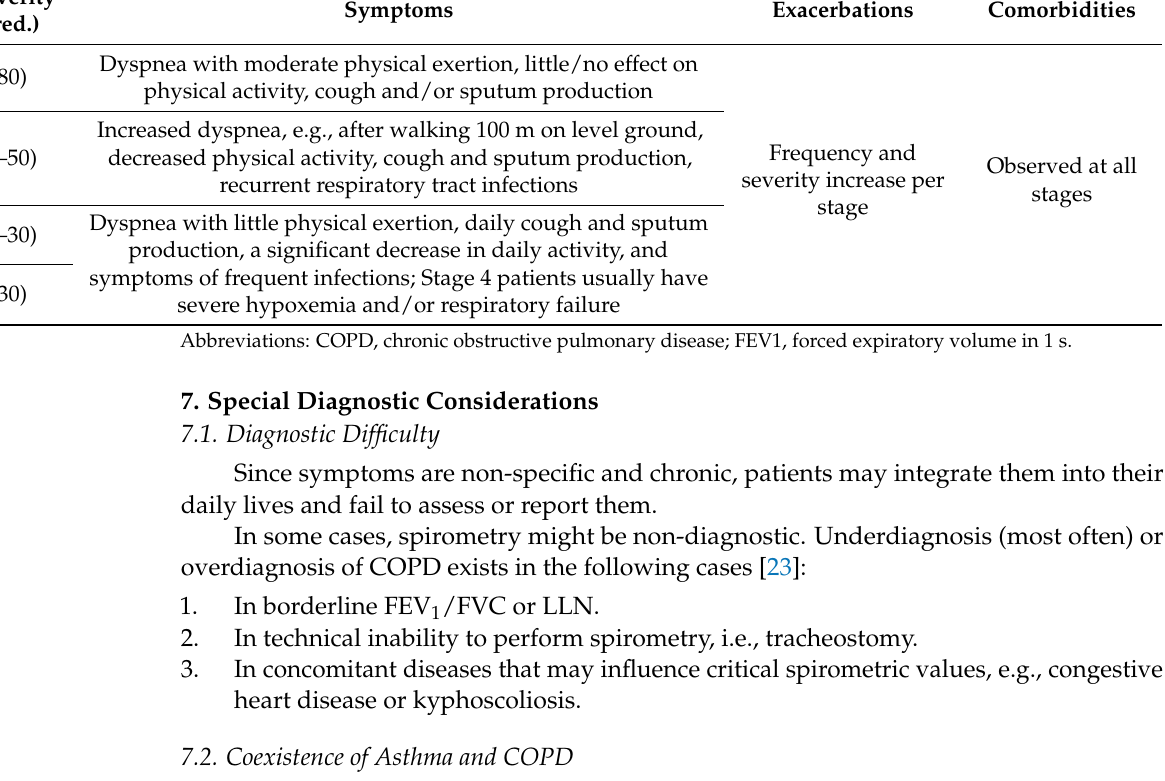
Table 2. COPD stages and association with symptoms, exacerbations, and comorbidities. Stages of